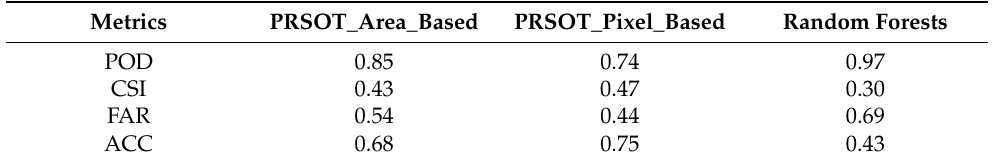
Table 2. Evaluation metrics for PRSOT_Area_based model, PRSOT_Pixel_based model and Ran- dom Forests.